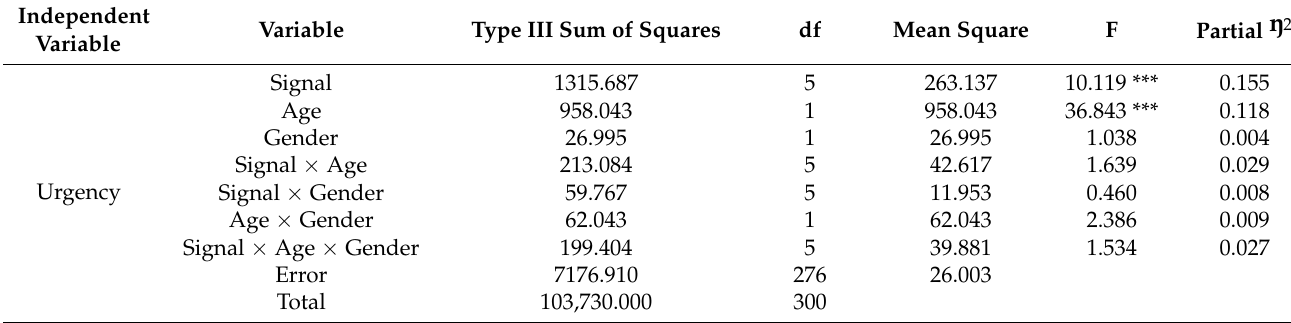
Table 3. The results of three-way analysis of variance (ANOVA) among signal, age and gender in arousal. Table 4. The results of three-way ANOVA among the type of fire alarm, age and gender for urgency. Independent Independent